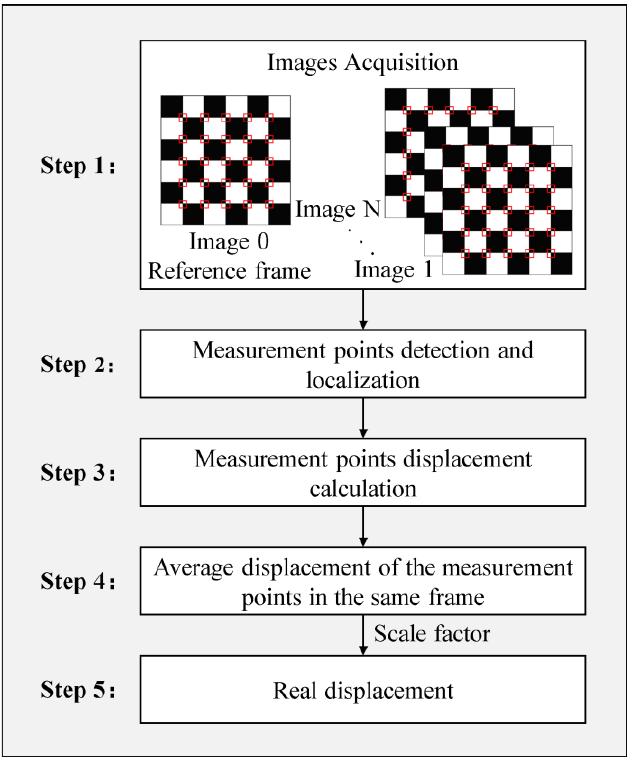
Figure 1. Workflow of the proposed